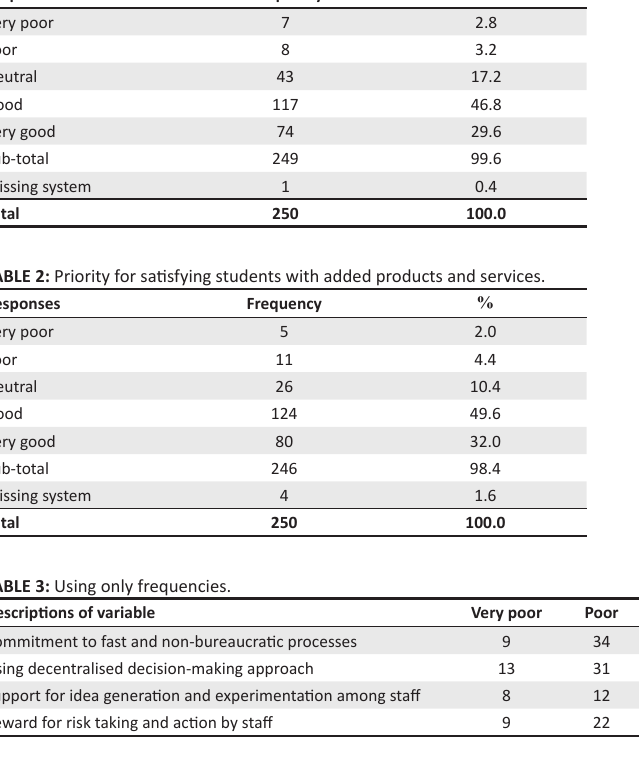
TABLE 1: Priority for developing new products and services to students. Responses